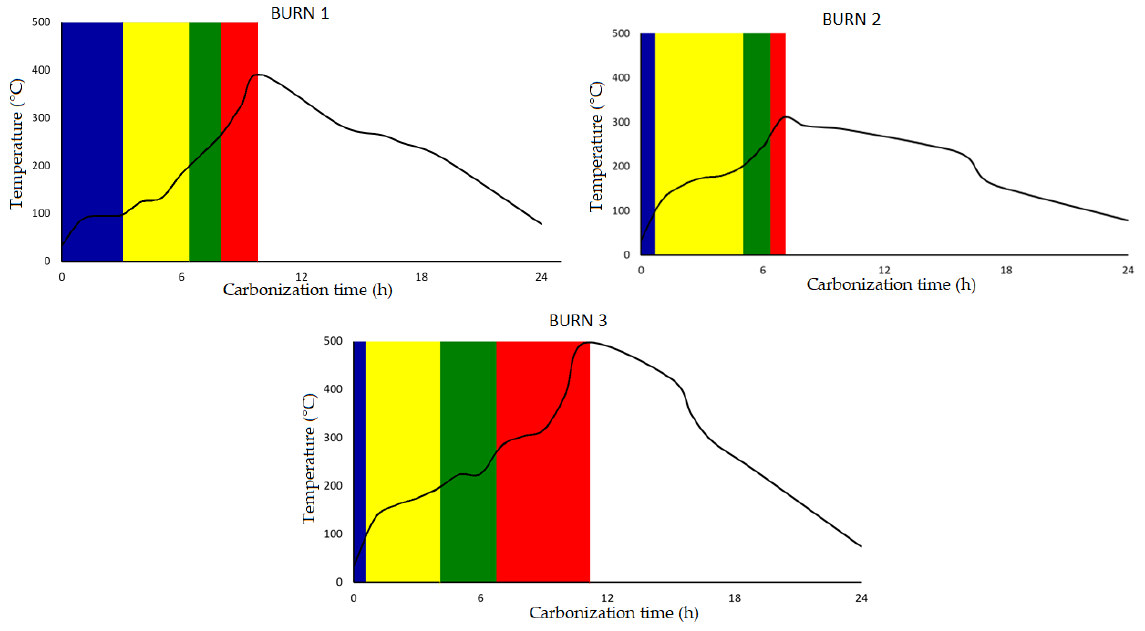
Figure 9. Heating ramps during carbonization in three burnings of industrial metal kilns. Blue color = phase 1, yellow color = phase 2, green color = phase 3, red color = phase 4, white color = phase 5. This carbonization process includes the following species: Ramón, Yaxnic, Zapote, and Zapotillo. Table 6. Burning time and heating ramps per phase during carbonization in industrial metal kilns.